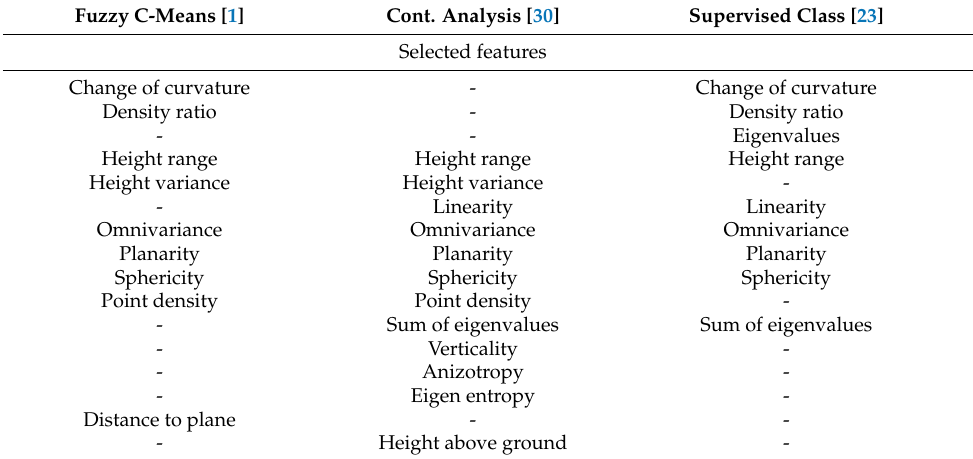
Table 3. Summary of training data and their